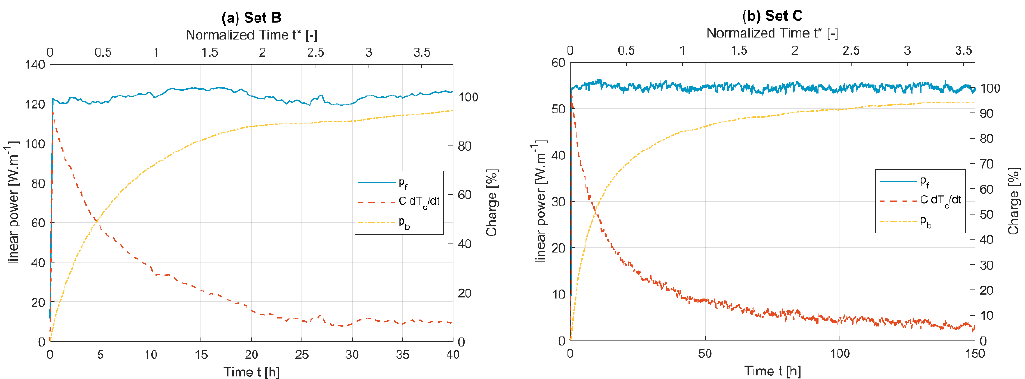
Figure 9. Evolution of linear powers computed by the RC model: for ( a ) set B, ( b ) set C. p f : power given by the fluid, C dT : transient power in the pile, p b : power at the borehole wall .